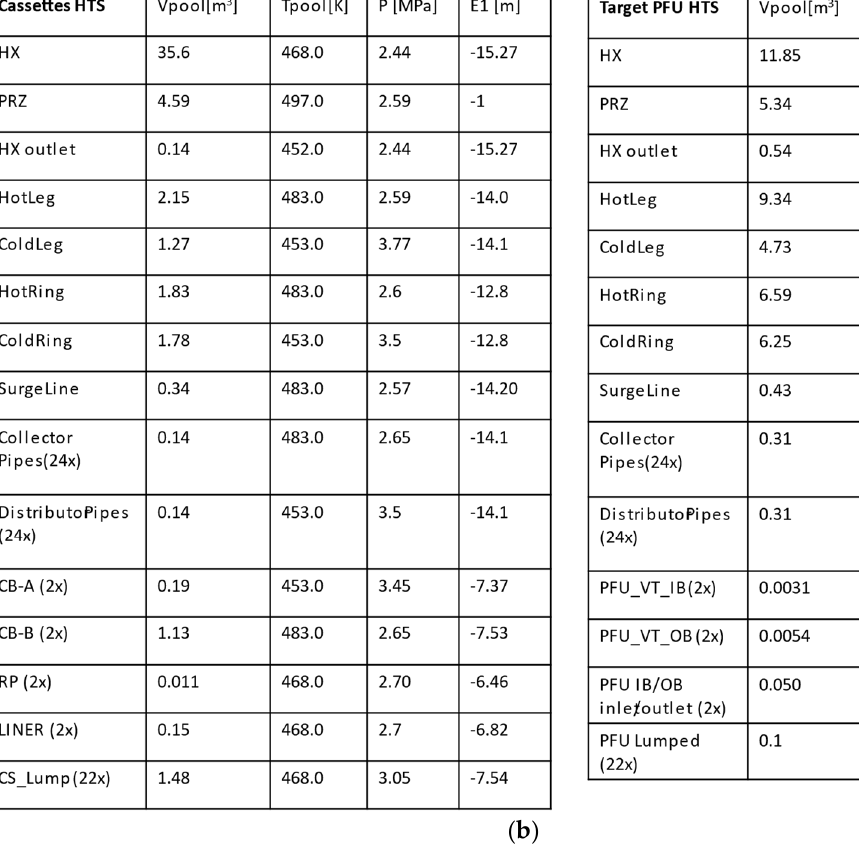
Figure 5. Overview of divertor system nodalization ( a ) and data for main divertor system CVs ( b ).